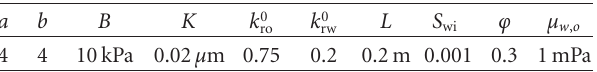
Table 1: Primary parameters from Pooladi-Darvish and Firooz- abadi